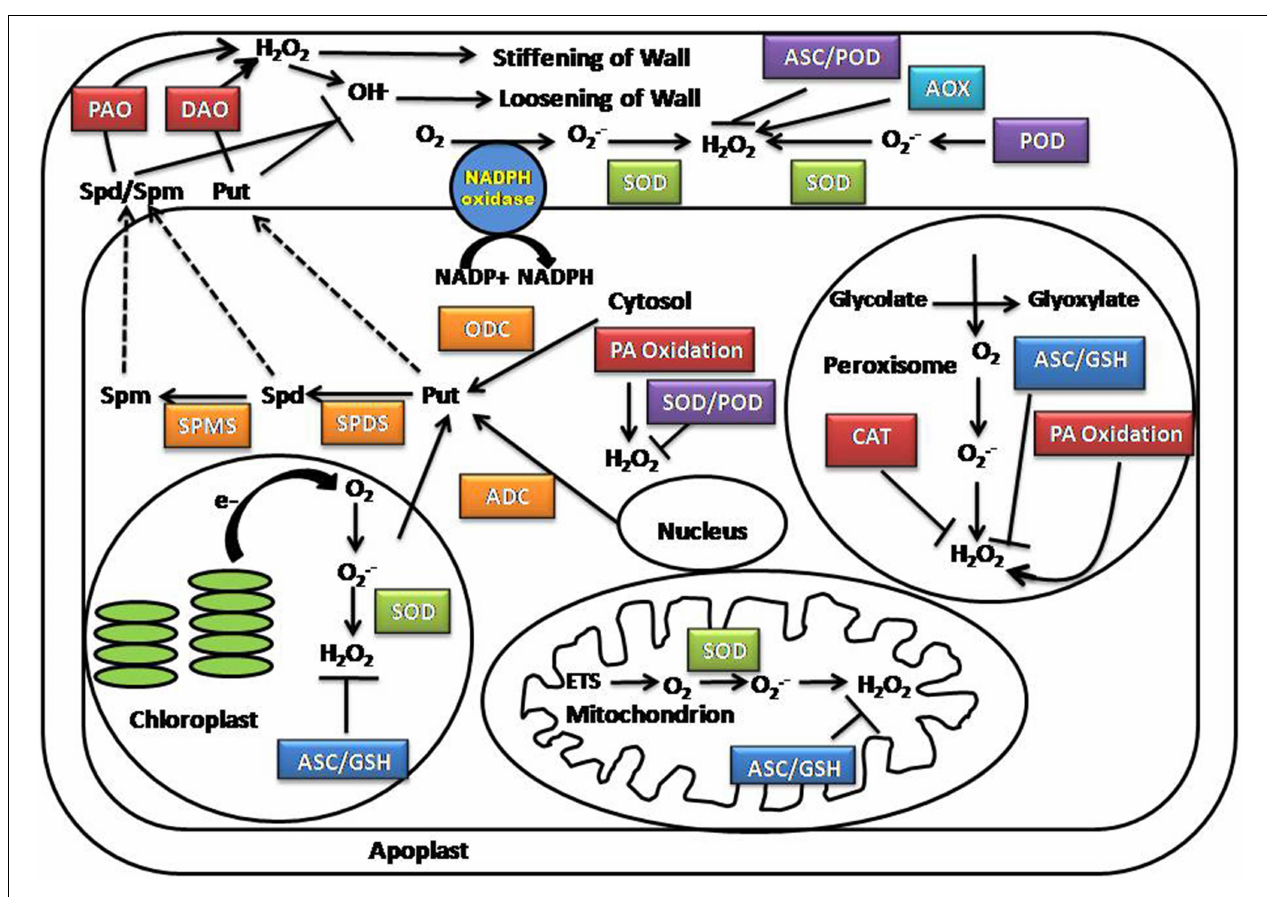
FIGURE 1 | Location of ROS and polyamine production in the cell. AOX, Alternative oxidase; ADC, Arginine decarboxylase; ASC, Ascorbate; APX, Ascorbate peroxidase; CAT, Catalase; DAO, Diamine oxidases; ETS,